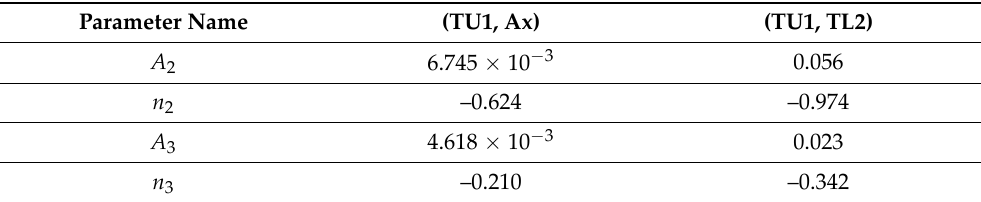
Table 4. Parameters of Equations (24) and (27) for two ways of supplying liquids to MRISF‑2 ( Q is in L/min, ε is in kW/kg).